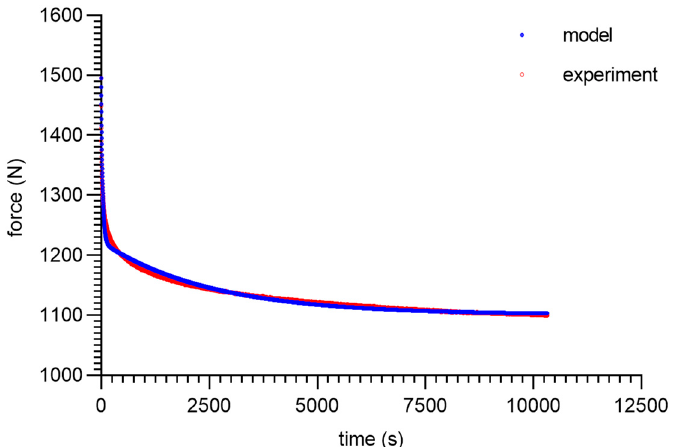
Figure 9. Material 80 ShA—five-parameter relaxation model and experimental data for ε = 50%.